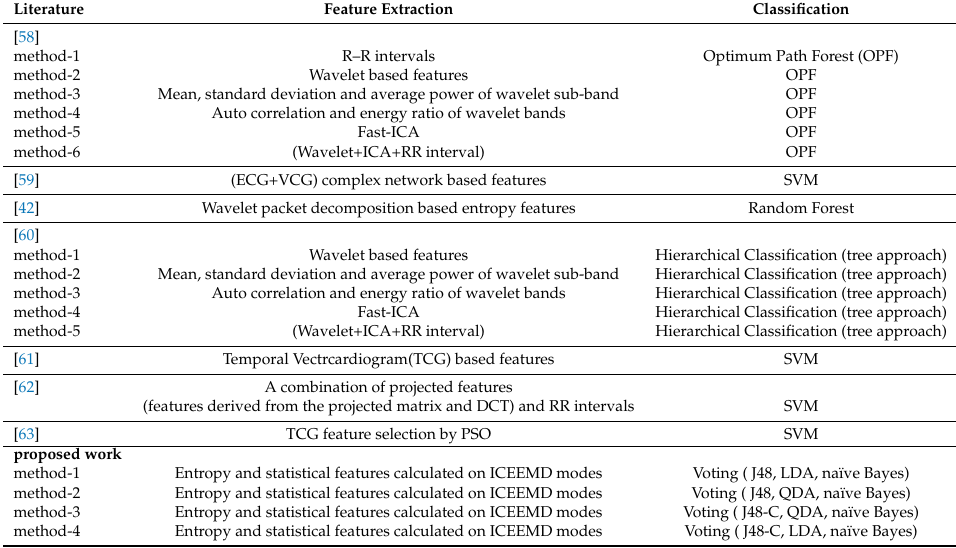
Table 27. Methodology description of recent state-of-the-art compared in our work. Literature